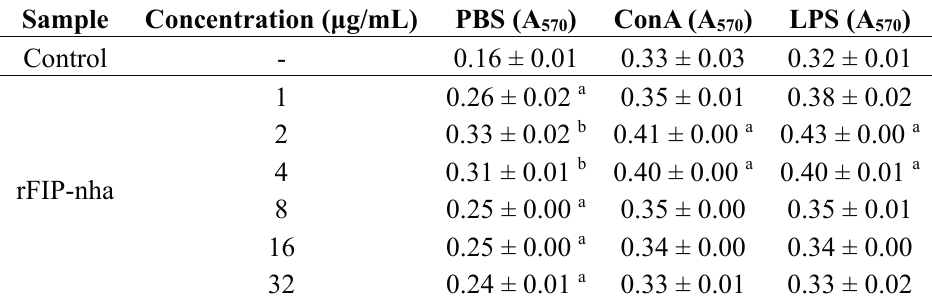
Table 1. Effects of rFIP-nha on lymphocyte proliferation (expressed at 570 nm). Values represent mean ± SD ( n = 3). a: p < 0.05; b: p < 0.01 vs. control.